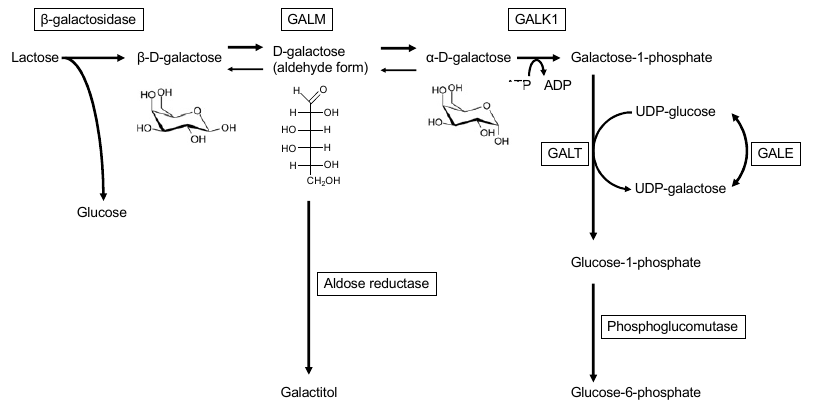
Figure 1. Enzymatic pathways related to galactose metabolism.